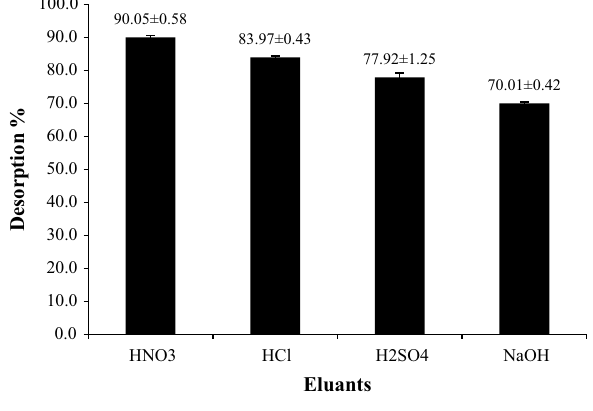
Fig. 9 Desorption efficiency of different eluants for desorption of Pb 2+ from bagasse biochar ± SD shown by error